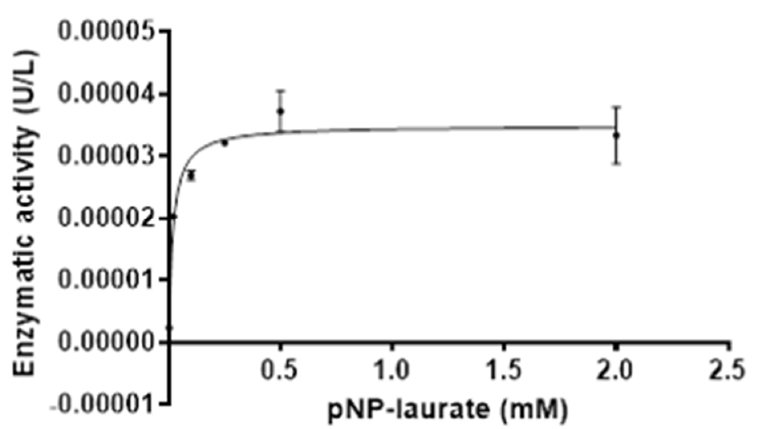
Figure 8. Enzyme kinetics for LipB12_A11 using varying concentrations of the substrate pNP-Laurate at 60 °C and pH 9. Michaelis–Menten non-linear regression was calculated using the GraphPad Prism software.